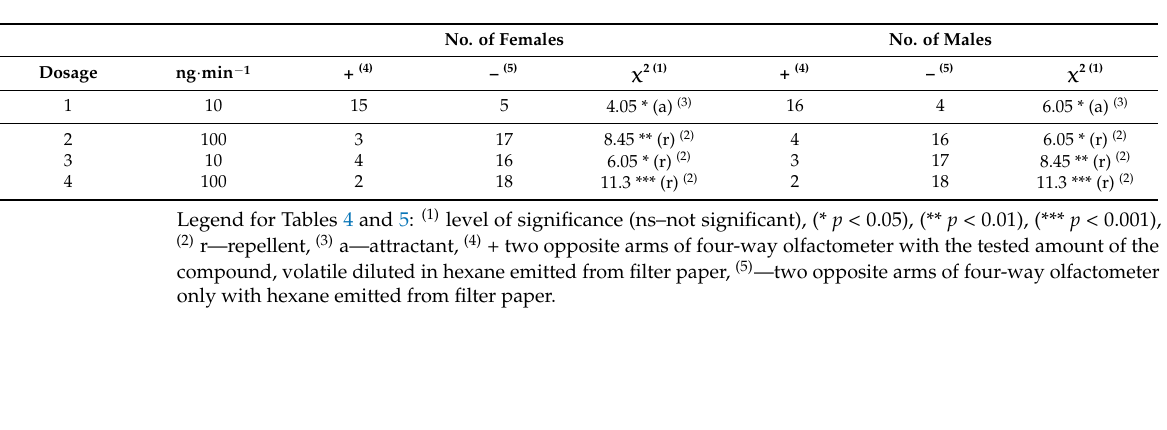
Figure 4. Heatmap for Pearson’s correlation coefficients between observed VOCs resulting from MJ-S treatment (* p < 0.05; ** p < 0.01; *** p < 0.001). Regarding the intensities (emission rates) of particular VOCs at the three time points chosen, the majority of the VOCs showed the highest release at 48 h after the stress in- duction. The clearest trend was observed for the “Serenada” variety with 3SL and MJ -S treatment. In addition, for the “Serenada” variety, and with MJ -V treatment, the highest released levels for C6 aldehydes and the corresponding alcohols were observed. The correlation coefficients demonstrate that the emission levels of the C6 aldehydes and alcohols, classified as Green Leaf Volatiles (GLVs), are well correlated, and especially so for those associa ted with mechanical wounding that imitated Bishop’s Mitre shield- bugs feeding on wheat. Of note is that the monitoring of MeJA application efficiency may be done by observing a single compound from ( Z )- β - ocimene, linalool, β -caryophyllene, and ( E )- β -farnesene group. Table 4. Effect of volatile odours released by wheat plants cv. Kandela following methyl jasmonate exposure at two levels (10 ng min − 1 and 100 ng min − 1 ) on the number of Aelia acuminata L. adult females and males choosing to enter an arm of a four-way olfactometer. One arm contained the combination of odours, whereas the other arm contained purified, humidified air and hexane solvent (no odour) to act as the